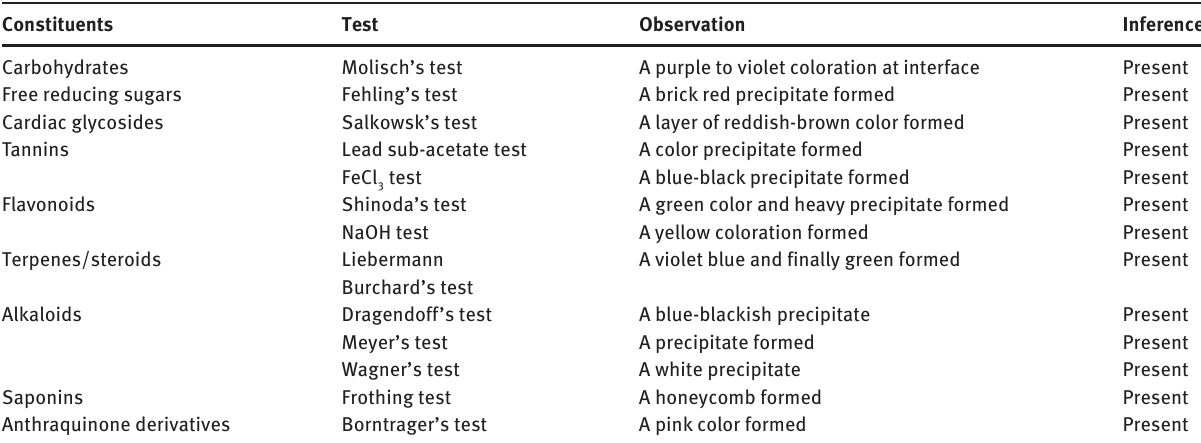
Table 1: Phytochemical screening of Andrographis paniculata (AP) water extracts. Constituents Test Carbohydrates Free reducing